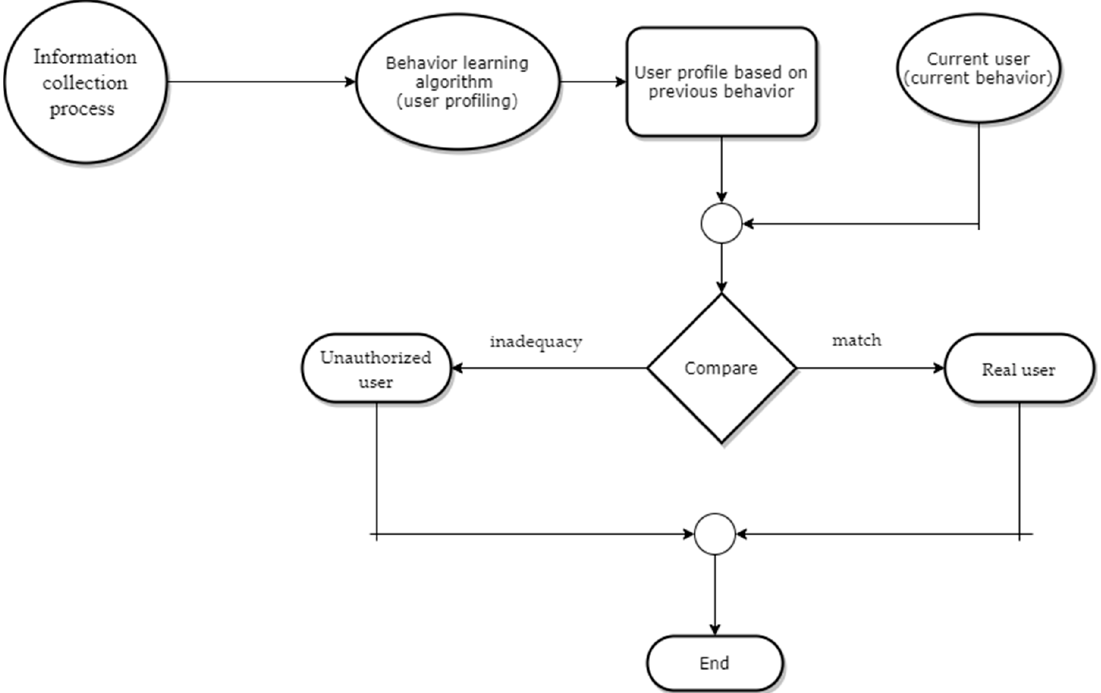
Figure 1. Identification of the user based on previous behavior.